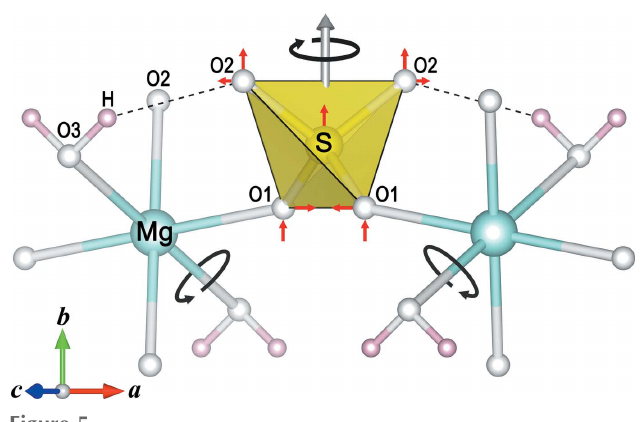
Figure 5 Fragment of the crystal structure of kieserite (MgSO 4 (cid:2) H 2 O) at 313 K, projected down the approximate c * direction, i.e. along [203]. On cooling, the black arrows show the direction of polyhedral rotations, red arrows indicate the components of the resulting positional shifts of the tetrahedral atoms in the plane of projection (see